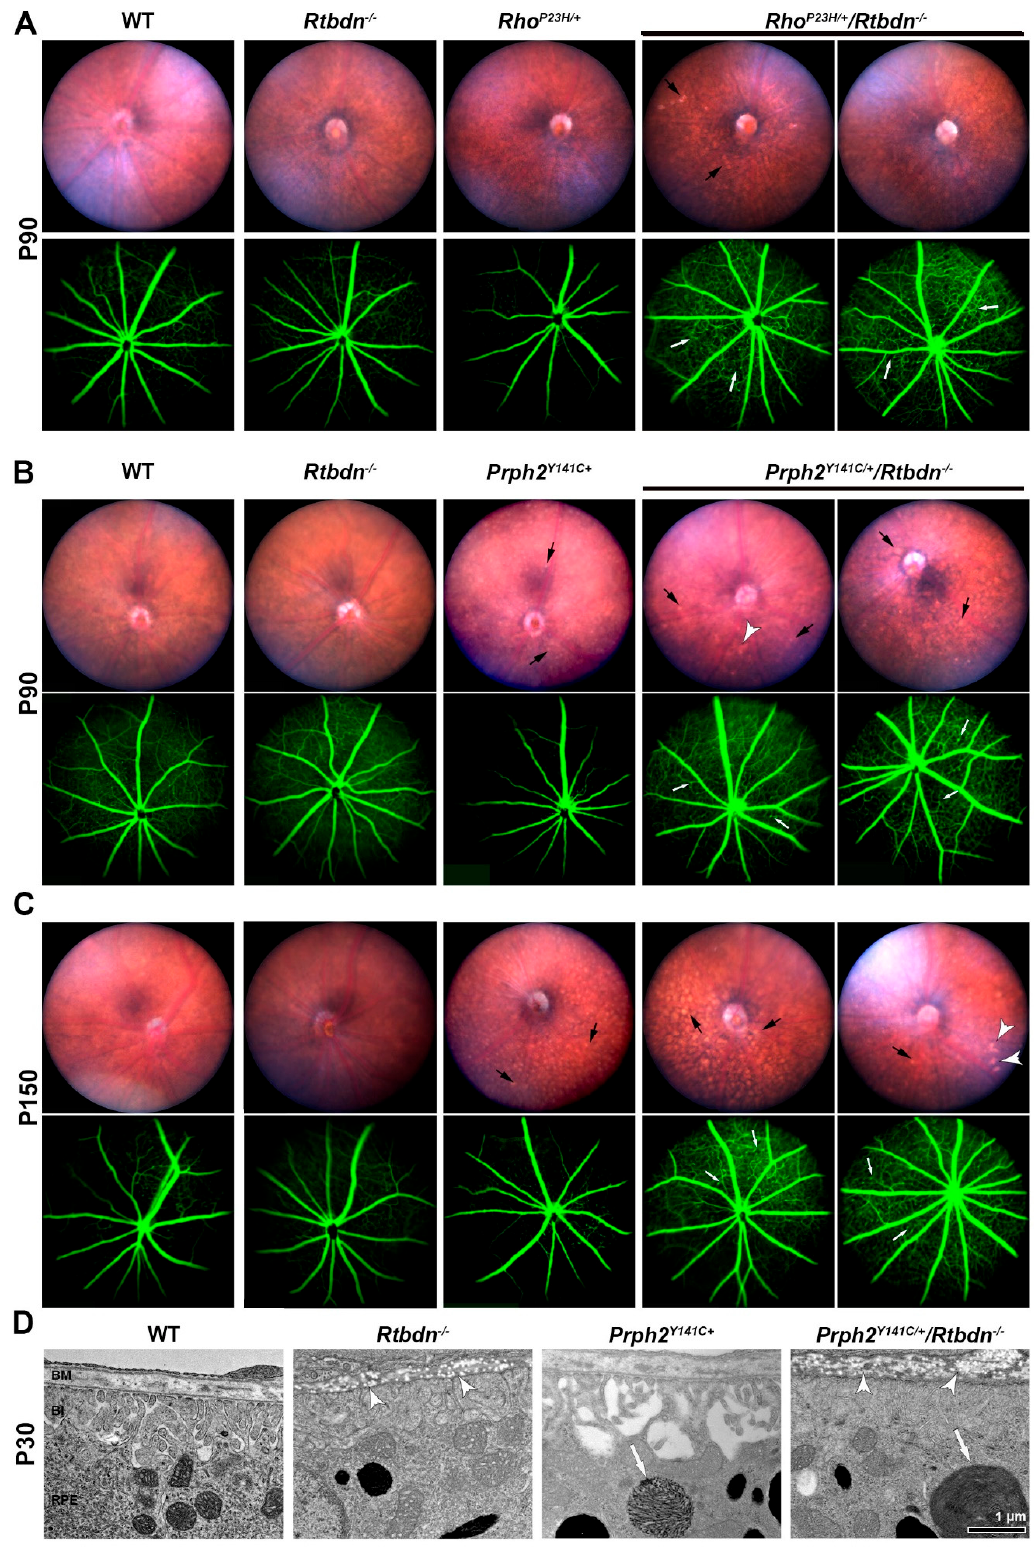
Figure 7. Non-photoreceptor effects of eliminating Rtbdn in degenerative models . ( A – C ) Shown are bright field fundus (top) and fluorescein angiograms (bottom) from mice of indicated genotypes at P90 ( A , B ) and P150 ( C ). Two different Rho P23H /+ / Rtbdn − / − and Prph2 Y141C /+ / Rtbdn − / − are displayed for each age. n = 8 − 10 for each genotype/age. White arrow; neovascular tufts, black arrow; mottling or other